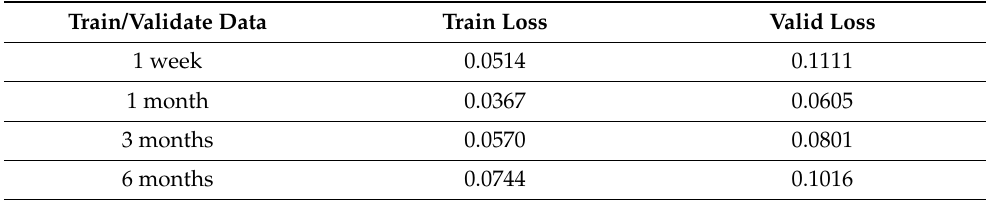
Table 6. Model training results according to the train/validate data